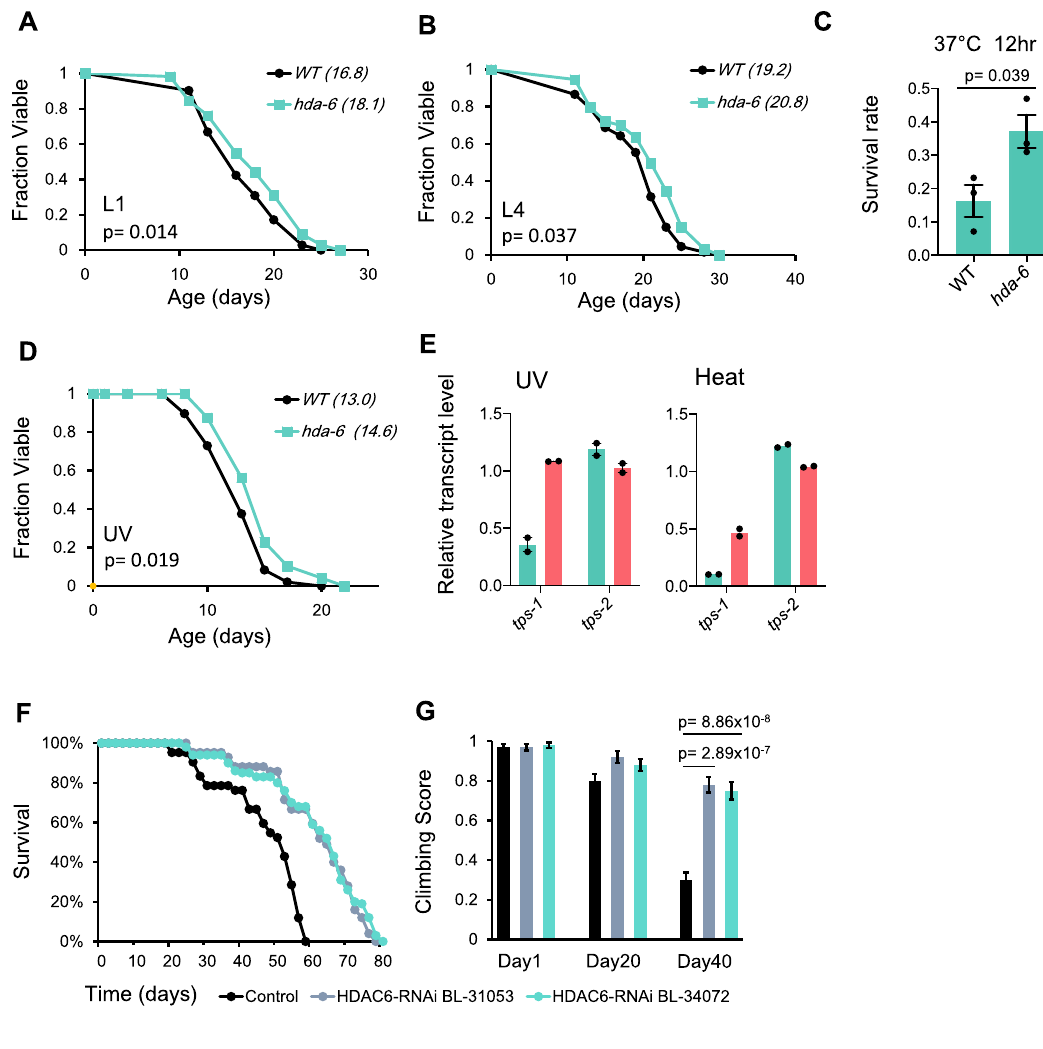
Fig. 6 Evolutionary conservation of HDA function. A Lifespan of WT and hda-6 knockdown worms, RNAi treatment started at L1 stage, n = 176 for WT and 169 for hda-6 . Statistical signi fi cance was calculated by two-sided Mann – Whitney U test. B Lifespan of WT and hda-6 knockdown worms, RNAi treatment started at L4 stage. n = 67 for WT and 93 for hda-6 . Statistical signi fi cance was calculated by two-sided Mann – Whitney U test. C Survival rate of WT and hda-6 knockdown worms after 12 h incubation in 37 °C. Error bars represent SEM, three independent experiments were performed with 32 worms in each group. Statistical signi fi cance was calculated by two-sided t -test. D Lifespan of WT and hda-6 knockdown worms under 0.08 J/cm 2 UV treatment. n = 50 for control and UV treatment group each. Statistical signi fi cance was calculated by two-sided Mann – Whitney U test. E RNA level of tps-1 and tps-2 genes in WT and hda-6 KO worms, under UV and heat. Two biological replicates were included in each group. F Lifespan analysis at 25 °C. N = 300 fl ies. Control group genotype: tub-Gal4, tub-Gal80ts / CyO; HDAC6 silencing group genotype: tub-Gal4, tub-Gal80ts/UAS-HDAC6-RNAi. Two independent HDAC6 RNAi lines (BL-31053 and BL-34072) were tested to avoid potential off-target effect. About 100 fl ies were tested for each group. G Climbing ability analysis at 5-, 20-, and 40-day-old adult fl ies. In all, 40 adult fl ies were tested in each age/genotype group. The results were presented as mean ± SEM. Statistical signi fi cance was calculated by two-sided Mann – Whitney U